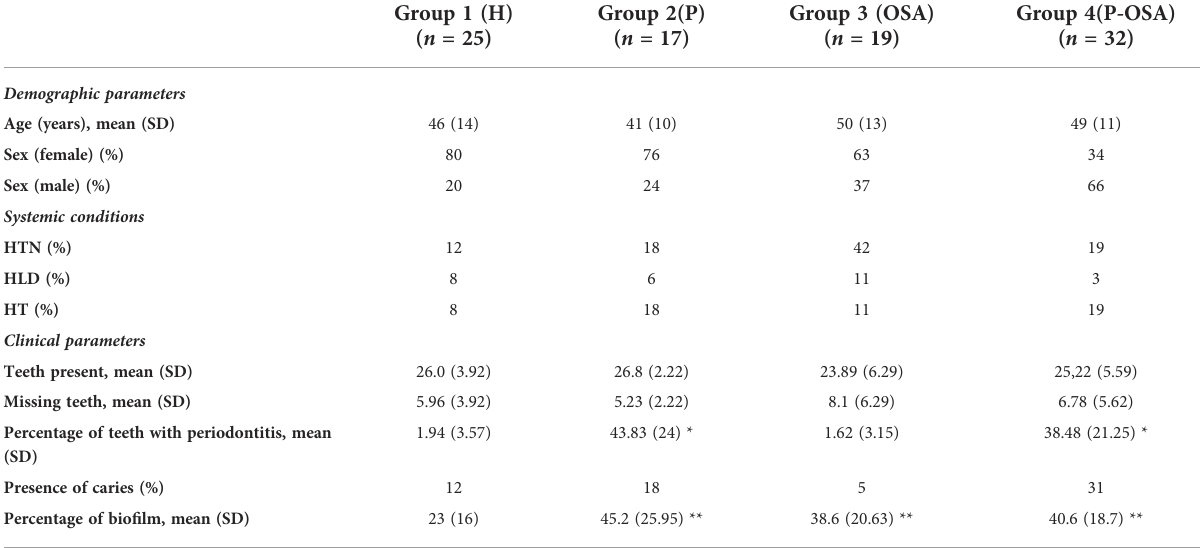
TABLE 1 Demographic data and clinical characteristics of the groups of